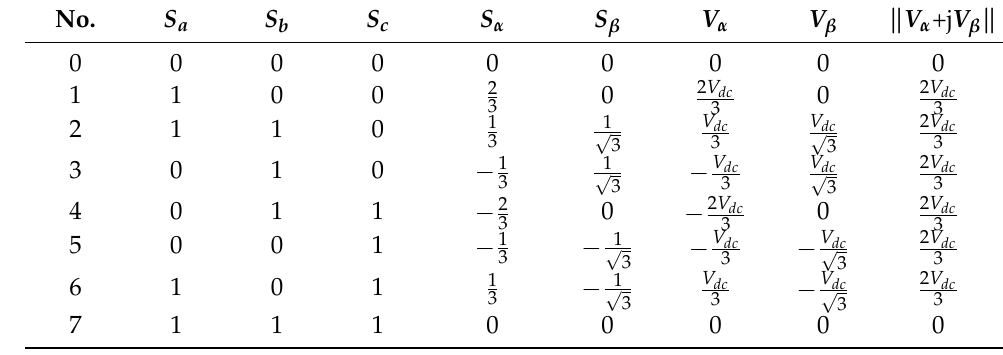
Table 1. Input voltage vectors of the AC/DC converter in the αβ coordinates.